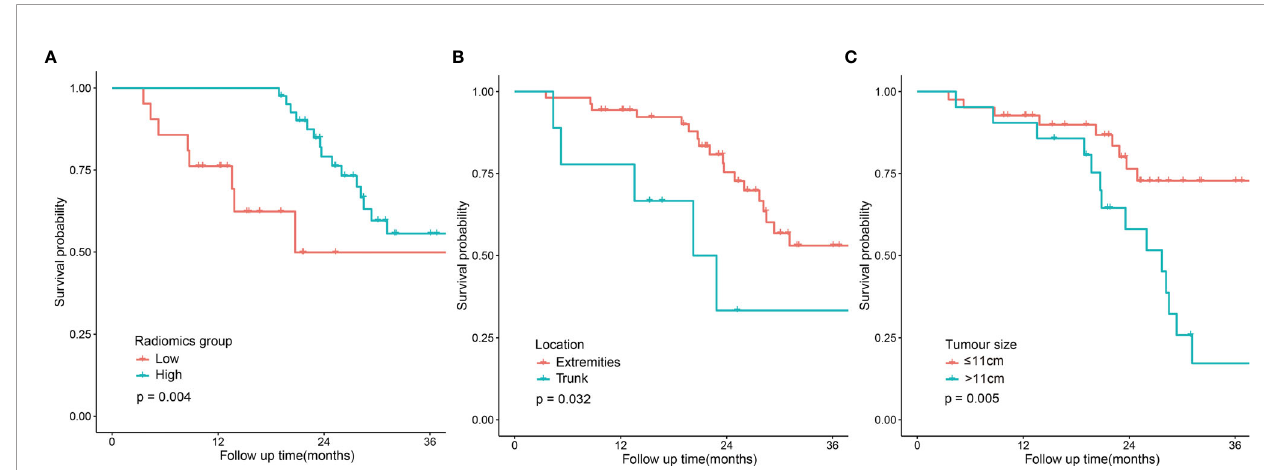
FIGURE 2 | | Disease-free survival curves according to patient risk strati fi cation. Survival curves strati fi ed by the radiomics score (high vs low) (A) , tumour location (trunk vs extremities) (B) and tumour size ( ≤ 11 cm vs <11 cm) (C) .